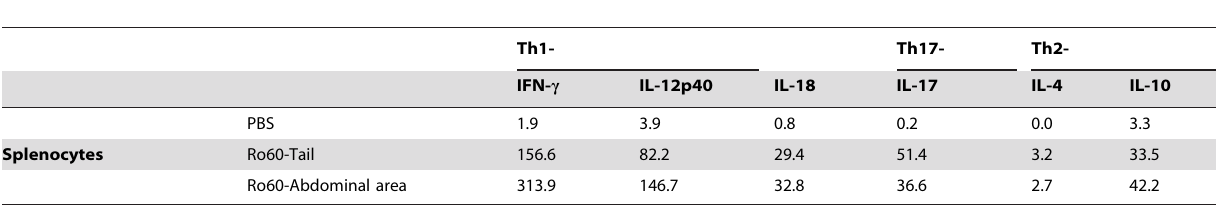
Table 1. Cytokine production after Ro60 peptide re-stimulated splenocytes from Balb/c